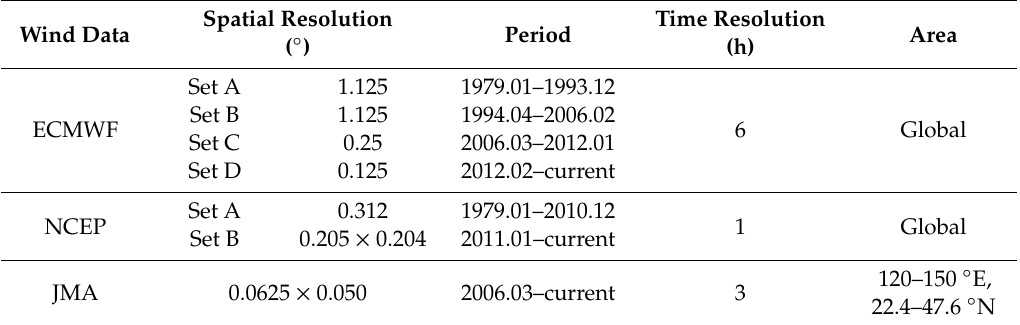
Table 1. Summary of European Centre for Medium-Range Weather (ECMWF), National Centers for Environmental Prediction (NCEP), and Japan Meteorological Agency (JMA) wind data.